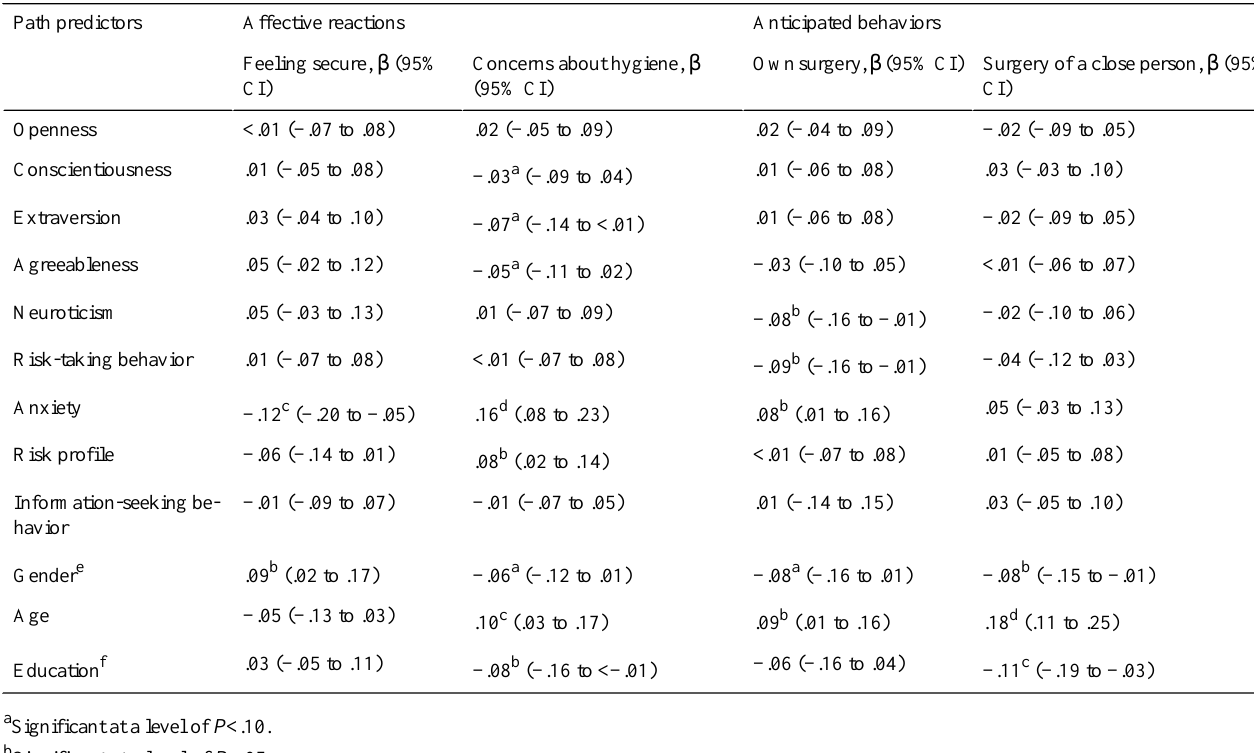
Table 4. Standardized regression coefficients of the path model, which was used to predict affective reactions and anticipated behaviors.